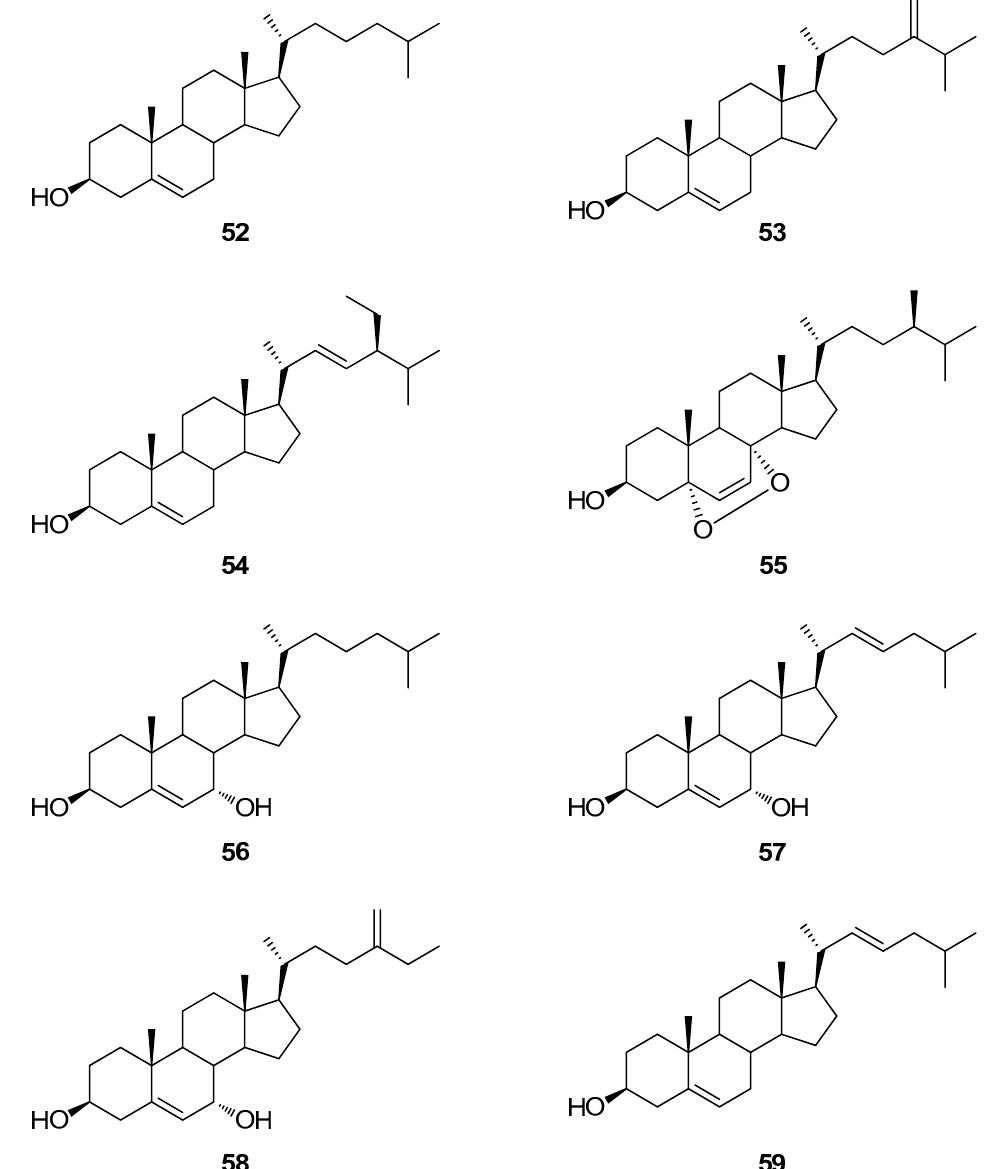
Figure 12. Structures of steroids ( 52 – 59 ) isolated from the Tunisian gorgonian coral E. singularis .